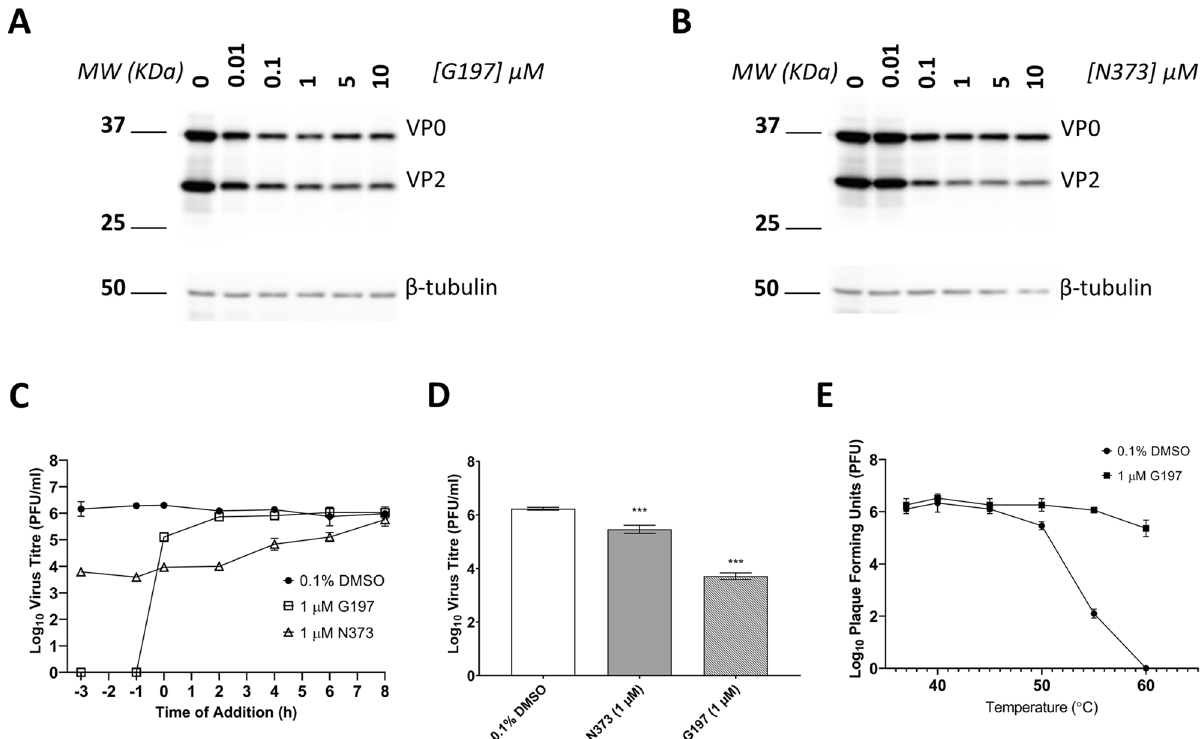
Figure 3. Treatment with G197 and N373 resulted decreased viral protein translation and treatment with G197 before virus entry resulted in greater inhibition efficacy consistent with the behaviour of capsid binding inhibitors. ( A ) Post-treatment of infected cells with G197 and ( B ) N373 resulted in a decrease in VP2 and precursor VP0 expression. Full length blots available were included as Supplementary Information 1. ( C ) Time- of-addition assay with G197 and N373 at 1 µM and negative control 0.1% DMSO. Treatment of cells with G197 before 0 h result in an abolishment of virus replication and addition of after virus has entered the cells were only able to reduce virus titres by a maximum of 1 Log 10 unit and no inhibition was observed from 2 h.p.i. N373 treatment gradually lost efficacy with delayed treatment up to 2 h.p.i. to no inhibition at 8 h.p.i. ( D ) Treatment of cells with G197 and N373 during the 1 h virus inoculation reduced virus titres significantly and G197 was more effective than N373. Statistical analysis for differences in virus titre due to drug treatment was performed with one-way ANOVA with Dunnett’s post-test: ***( p < 0.005). ( E ) Thermal stability of EV-A71 was assessed by incubating virus suspensions at temperatures from 37 to 60 °C in the presence of 0.1% DMSO or 1 µM G197. The presence of G197 improved the thermal stability of virus particles at elevated N373 inhibits the activity of PI4KIIIβ in vitro and G197 is a capsid‑binding inhibitor of EV‑A71. PI4KIIIβ than PI4KIIIα (Supplementary Fig. S1), confirming its in vitro activity as a specific PI4KIIIβ inhibi- tor. To confirm the function of G197 as a capsid binding inhibitor of EV-A71, a time-of-addition assay was